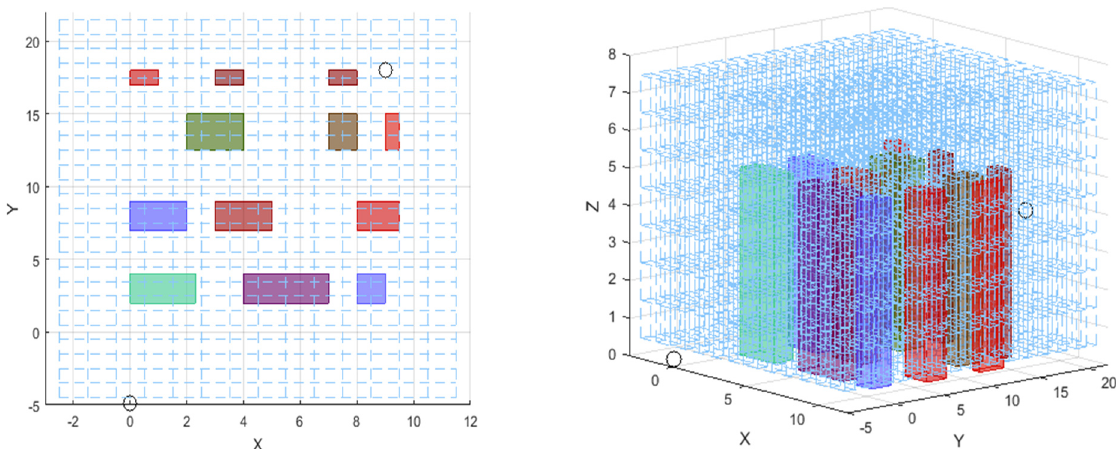
Figure 5. Meshing of the obstacle-cluttered environment (2D and 3D views).